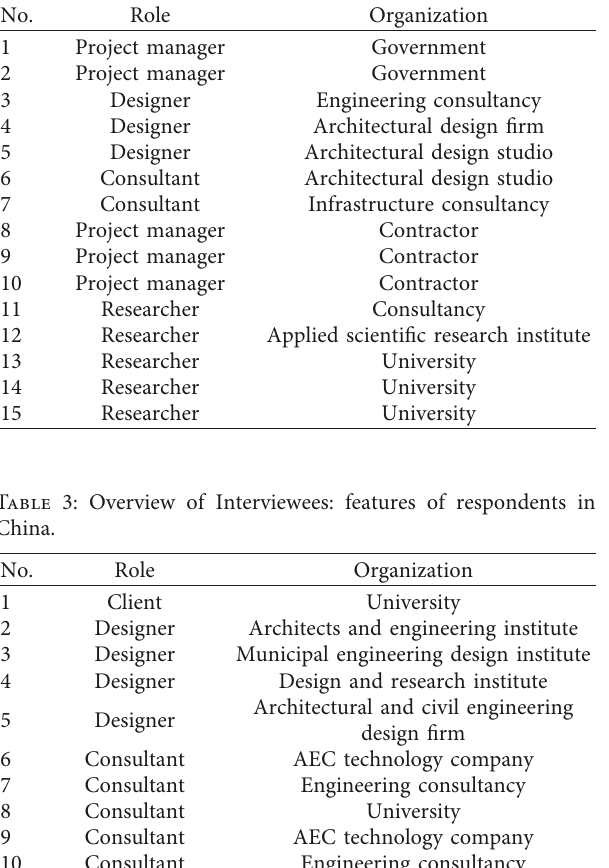
Table 2: Overview of Interviewees: features of respondents in Europe.